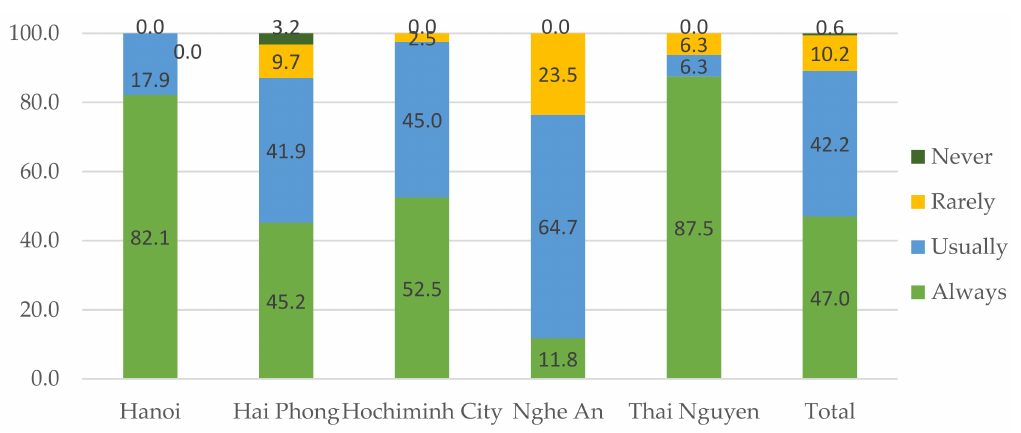
Figure 3. Condom use among FSWs (female sex workers) (%).